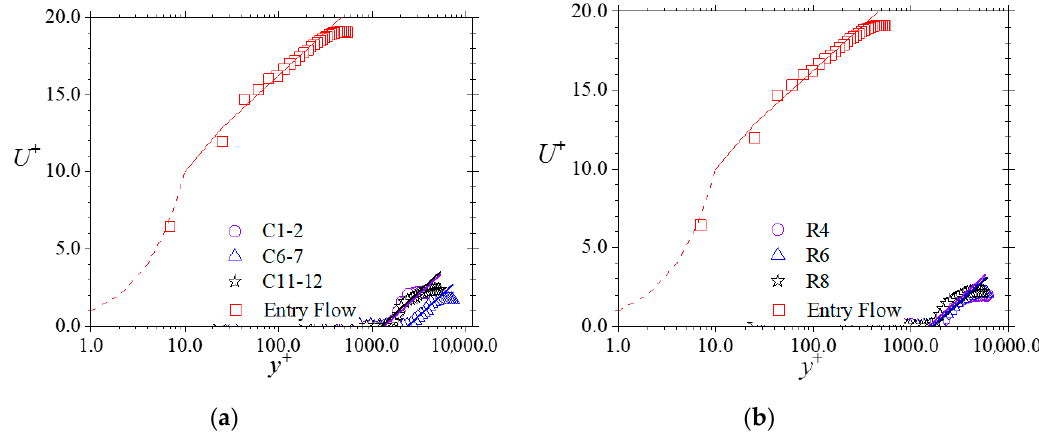
Figure 12. Mean streamwise line-averaged velocity profiles in inner coordinates for selected Test B conditions. Plots in ( a ) show streamwise variations compared with entry flow. Plots in ( b ) show spanwise variations compared with entry flow. The solid red line represents log law (Equation (2)). The red dashed line represents the law of the wall U + = y + . Other solid lines represent modified log law for rough walls (Equation (3)). The denominations C and R respectively stand for columns and rows, and are illustrated in Figure 1. Black-filled boxes are the results for Test A , and red-open boxes are the results for Test B .